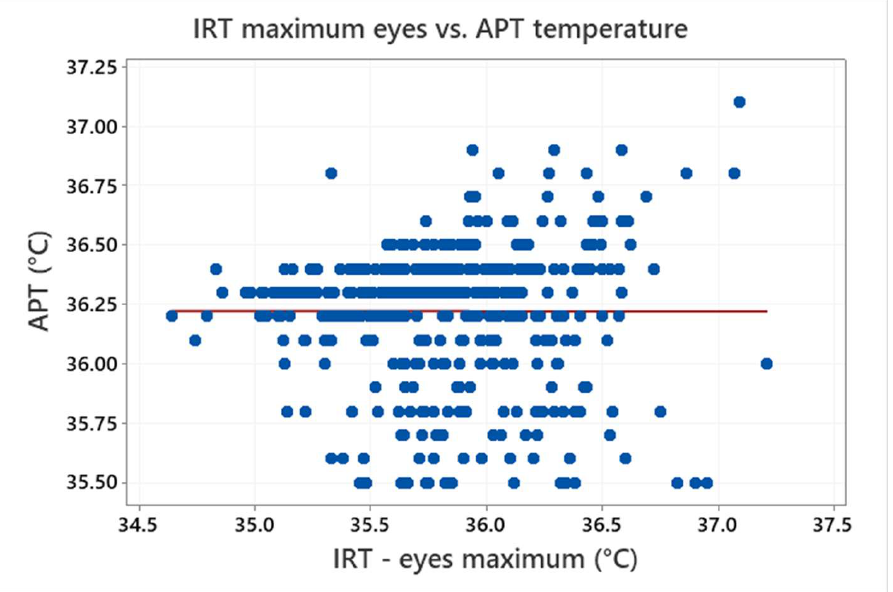
Figure 9. Relationship between the IRT eyes maximum temperature and APT temperature (the symbols represent measured values and the line shows their linear regression).